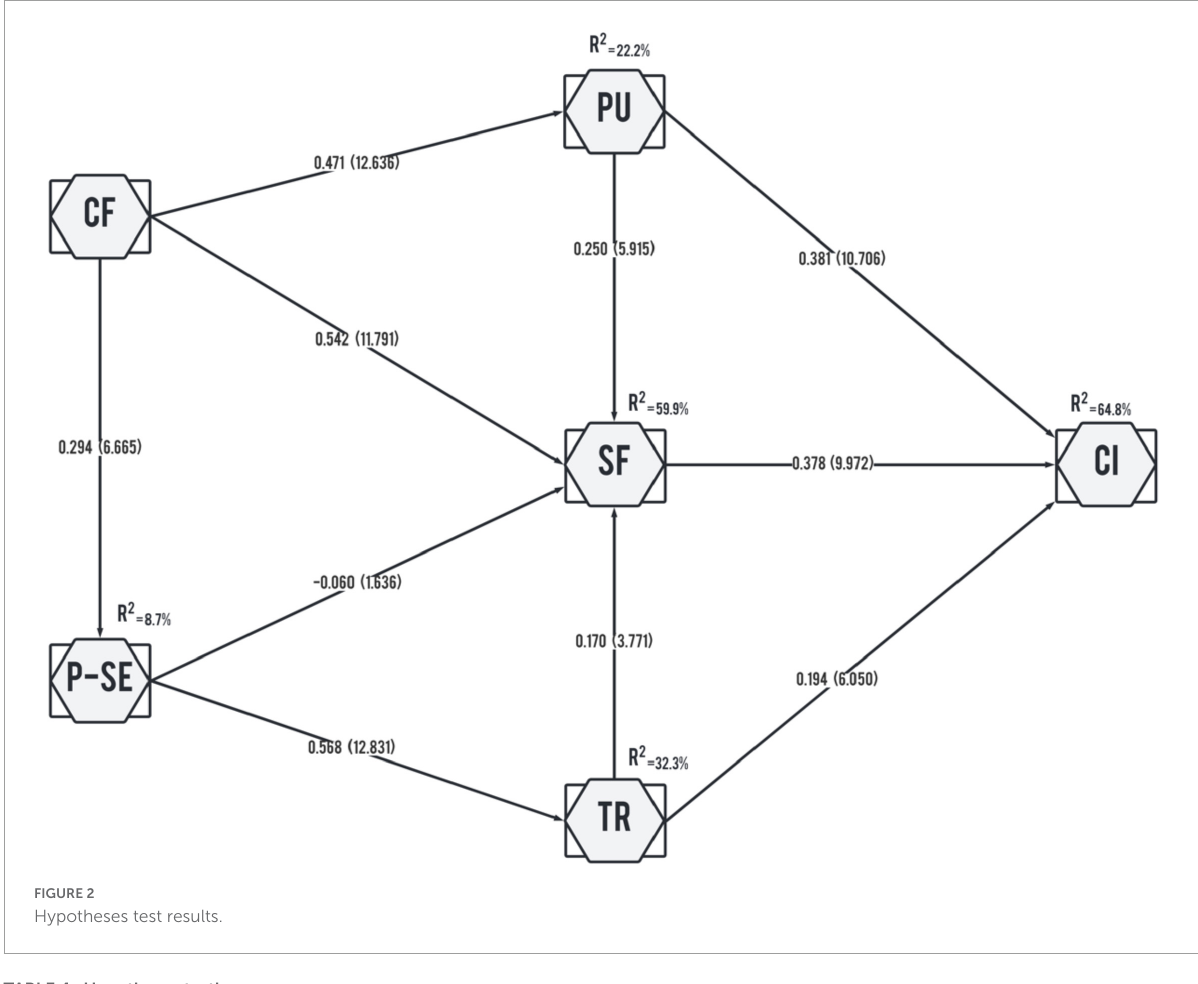
TABLE 4 Hypotheses